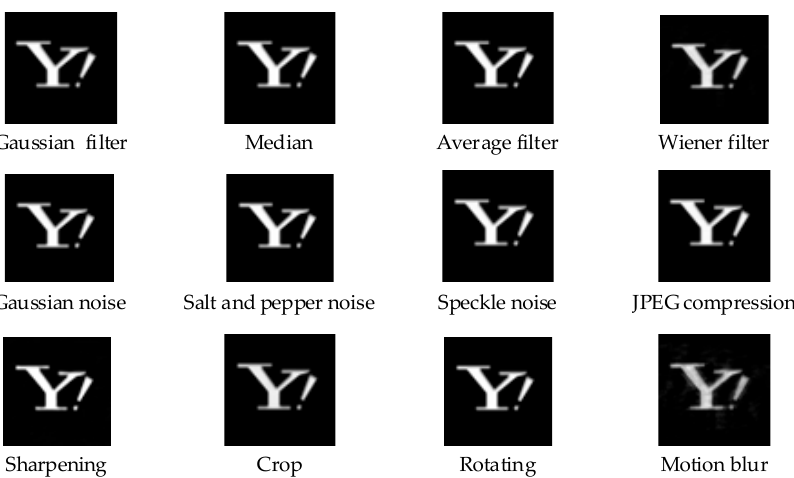
Figure 9. Watermarked images under various attacks.